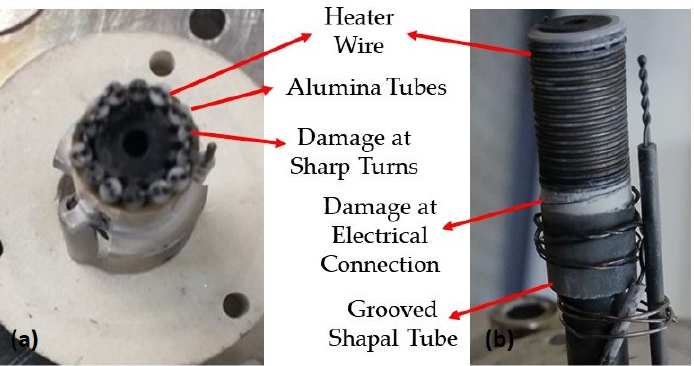
Figure 3. ( a ) Damaged heater of the first conventional design; ( b ) Damaged heater of the second conventional